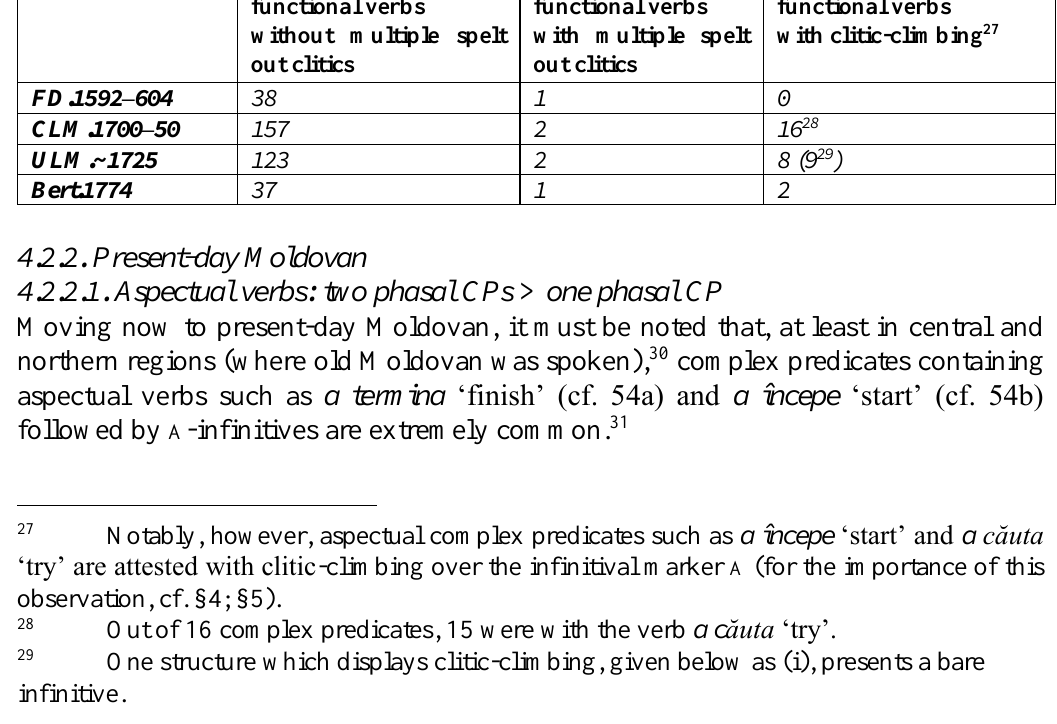
functional verbs with clitic-climbing 27